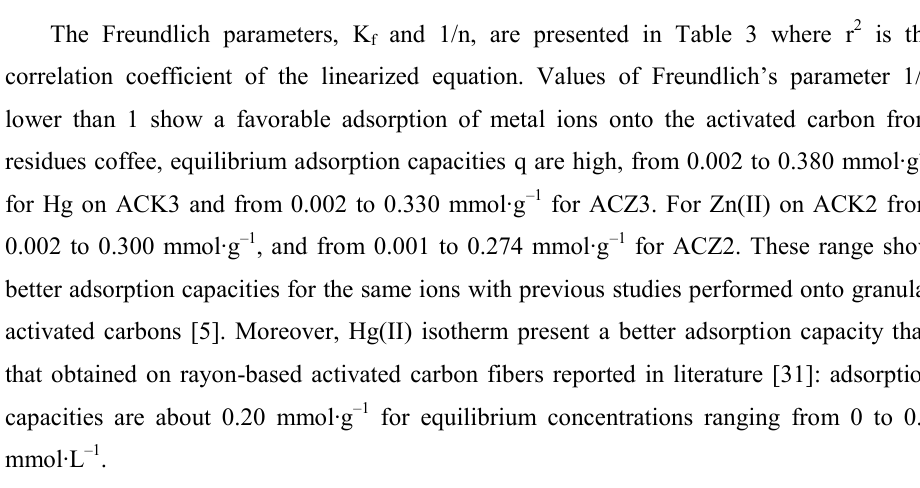
Figure 4. Monocomponent isotherm of Hg(II)) onto ACK3 and ACZ3.